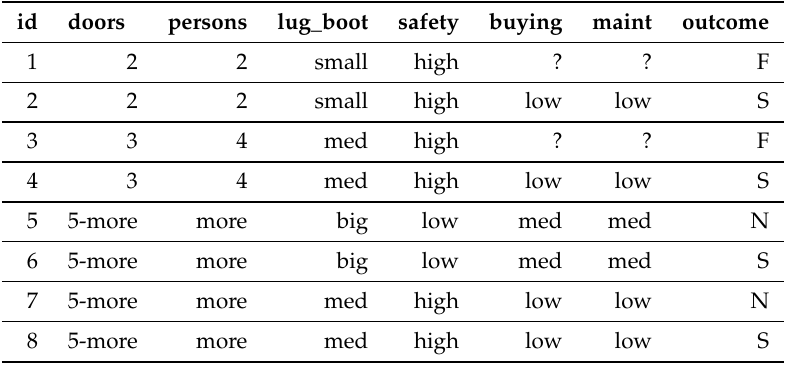
Table 2. Some contradictory negotiations with C 2 . An additional “id” field has been added to refer to these examples in the